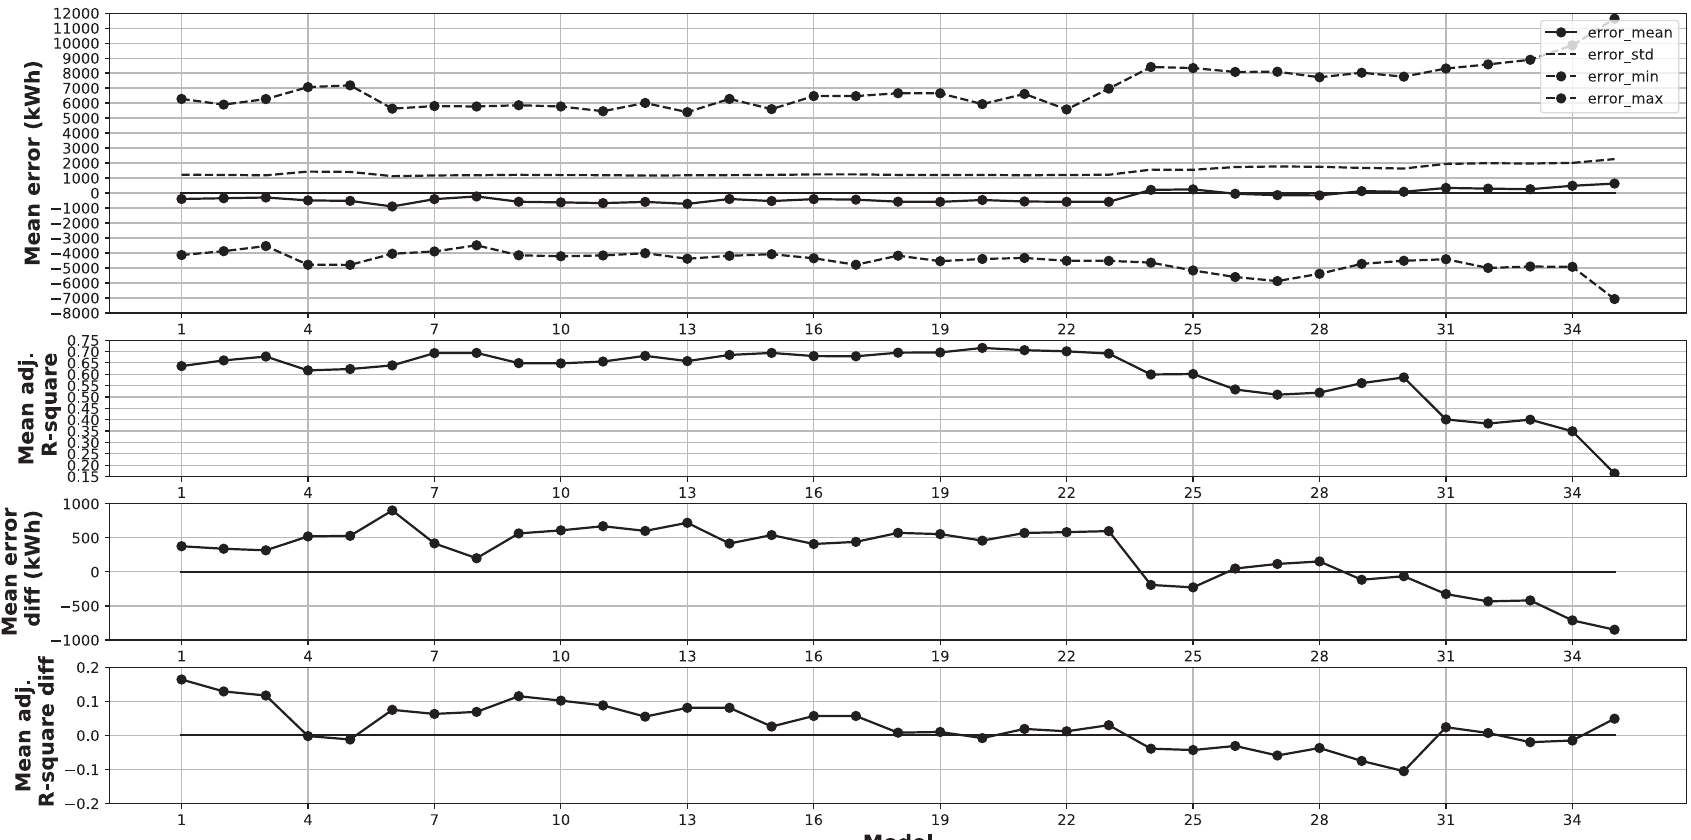
Figure A2. The modeling results from the algorithmic approach. Top panels: Mean error plots for the best models for each of the 36 models in the algorithmic approach. The solid line with circles, ∆ µ . The dashed line without circles, ∆ σ . The dashed lines with circles, ∆ min and ∆ max , respectively. The solid line represents zero error and is used as reference for clarity purposes. The ¯ R 2 µ of each model. The model with the highest ¯ R 2 µ is model 21 with ¯ R 2 µ = 0.716. Bottom panels: The difference in ∆ µ and ¯ R 2 µ between the training and the test